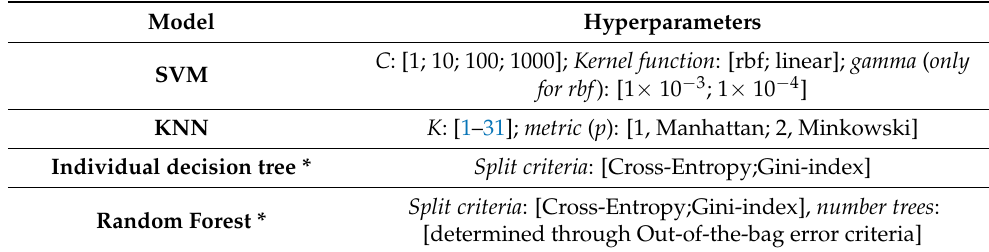
Table 7. Model hyperparameters and their range of values.